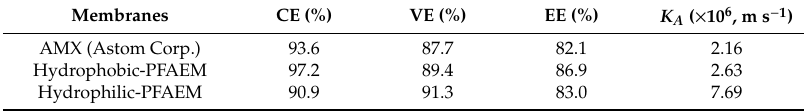
Figure 7. VRFB charge–discharge performances of ( a ) AMX, ( b ) Hydrophobic-PTFE based PFAEM, and ( c ) Hydrophilic-PTFE based PFAEM. Table 4. Various characteristics of commercial and prepared membranes. Table 4. Various characteristics of commercial and prepared membranes.